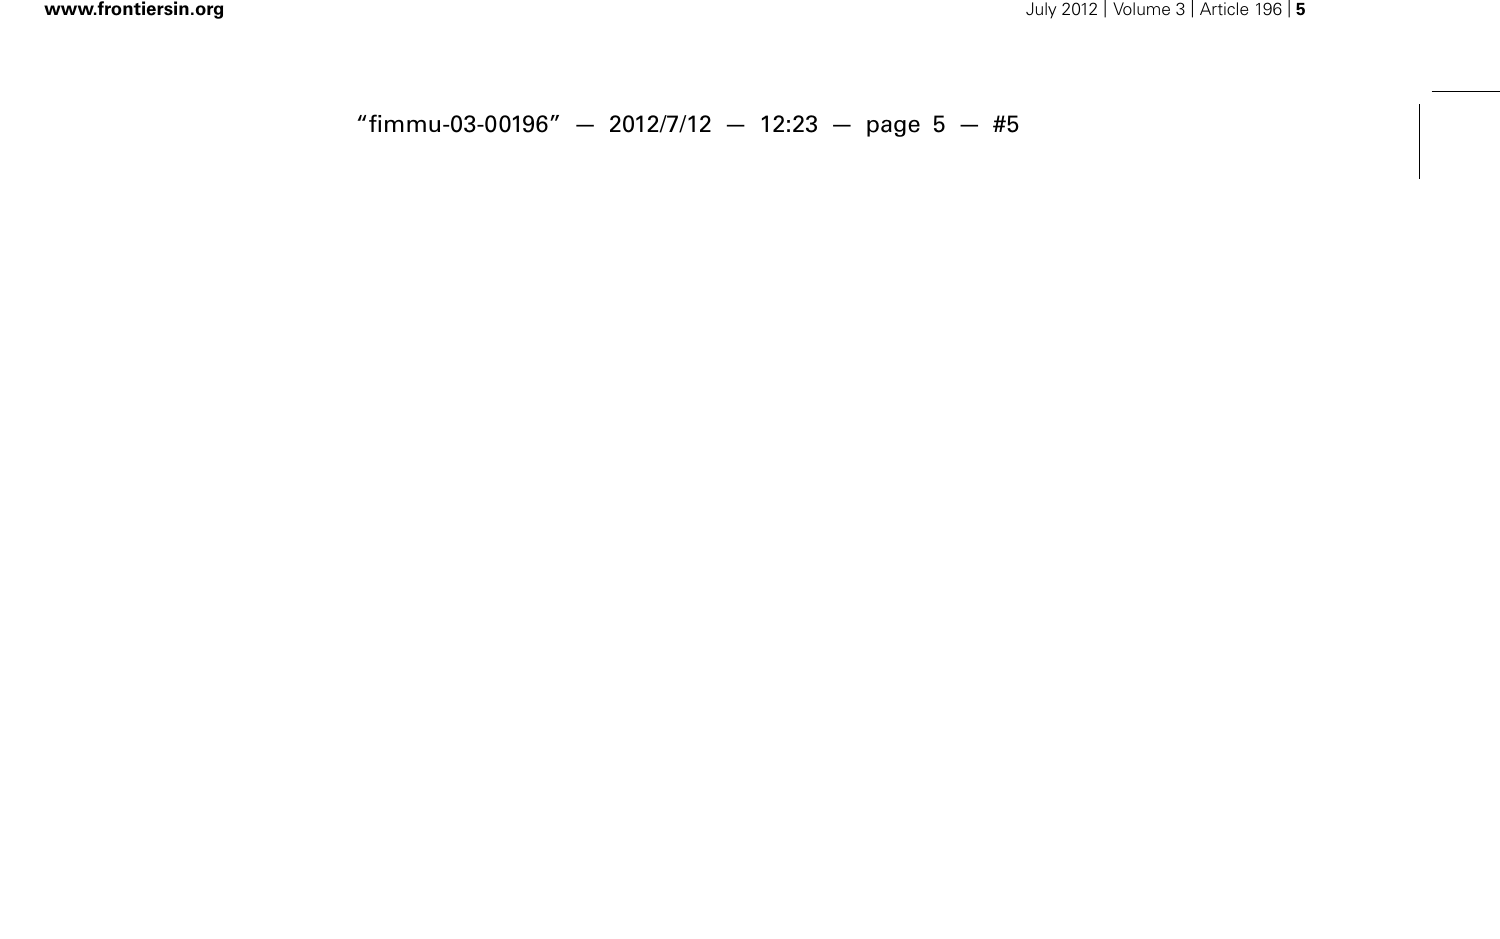
mice in the control group (left, bottom).The histogram shows percent of islets with insulitis (filled bars), peri-insulitis (shaded bars) or no insulitis (open bar) in anti-FasL (120 islets) and control (42 islets) groups. (C) Treatment led to an only mild and transient increase in DNT cells. PBL were stained and the frequency ofTCR + CD4 − CD8 − (DN) cells relative to totalT cells was determined. Results are expressed as mean ± SEM. (D) Anti-FasL treated NOD-wt mice were grafted with syngeneic skins (left) or allogeneic (right) skin grafts from C3H mice 15 weeks after the last injection. The allograft skins were rejected within 7 days (3/3). Data adapted from Mohamood etal.